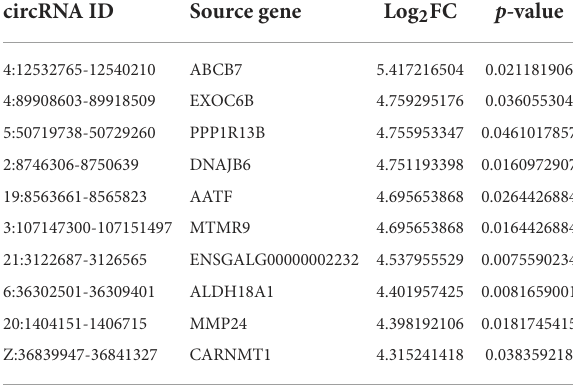
TABLE 1 The top 10 most up-regulated circular RNAs (circRNAs) in the avian pathogenic E. coli infected HD11 cells compared with the wild type HD11 cells.